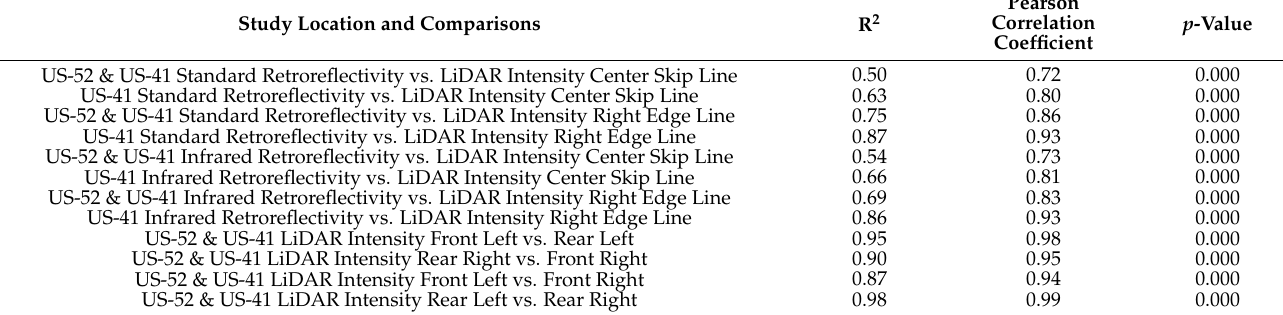
Table 1. Summary of statistical analysis.